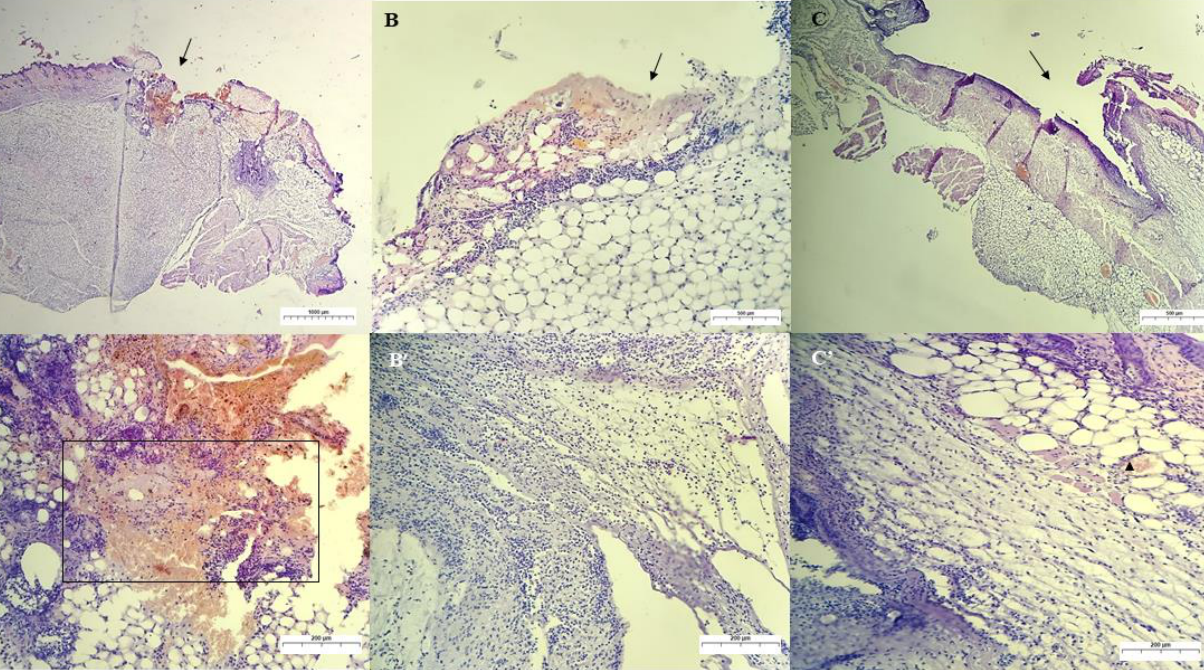
Figure 8 . Evolution of the skin lesion diameter in mice on 1st, 3rd, 7th, 14th, and 21st days of treat- ment with: Group I — physiological serum (PS); Group II — chicha hydrogel (GChi); and Group III — chicha hydrogel with 0.02 g mL −1 nerolidol (GChiN2).